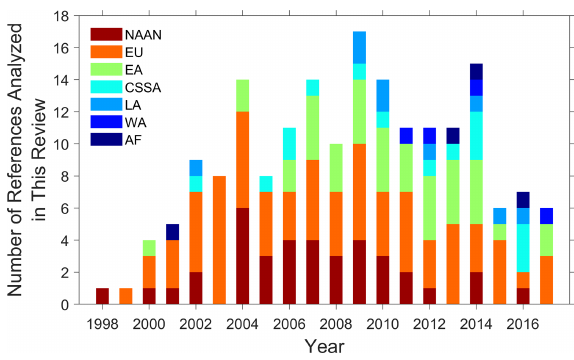
Figure 4. Temporal and geographical distribution by year of the urban PSD references analyzed in this study (1998–2017). The geographical regions include North America, Australia, and New Zealand (NAAN), Europe (EU), East Asia (EA), Central, South, and Southeast Asia (CSSA), Latin America (LA), West Asia (WA), and Africa